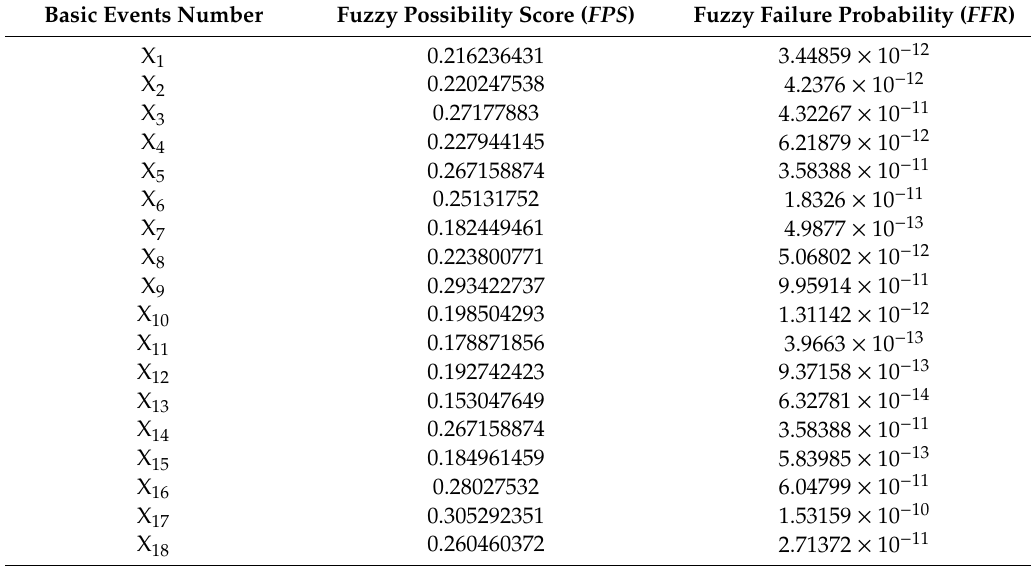
Table 5. Fuzzy probability of basic